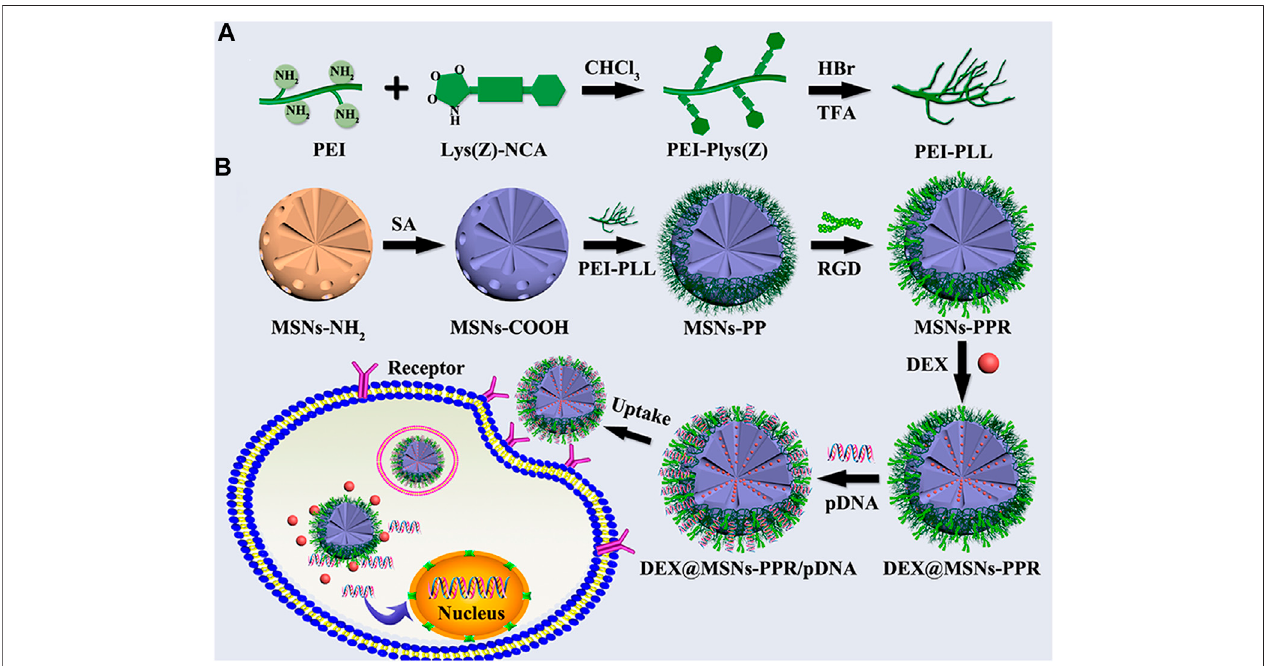
FIGURE 6 | (A) Reaction scheme for the synthesis of PEI-PLL copolymers. (B) Schematic illustration for the preparation of PEI-PLL and RGD-conjugated MSNs- based nanocarrier and codelivery of pDNA and drug into cells. Reprinted with permission from Zhou et al. (2019). Copyright © 2019 American Chemical Society.